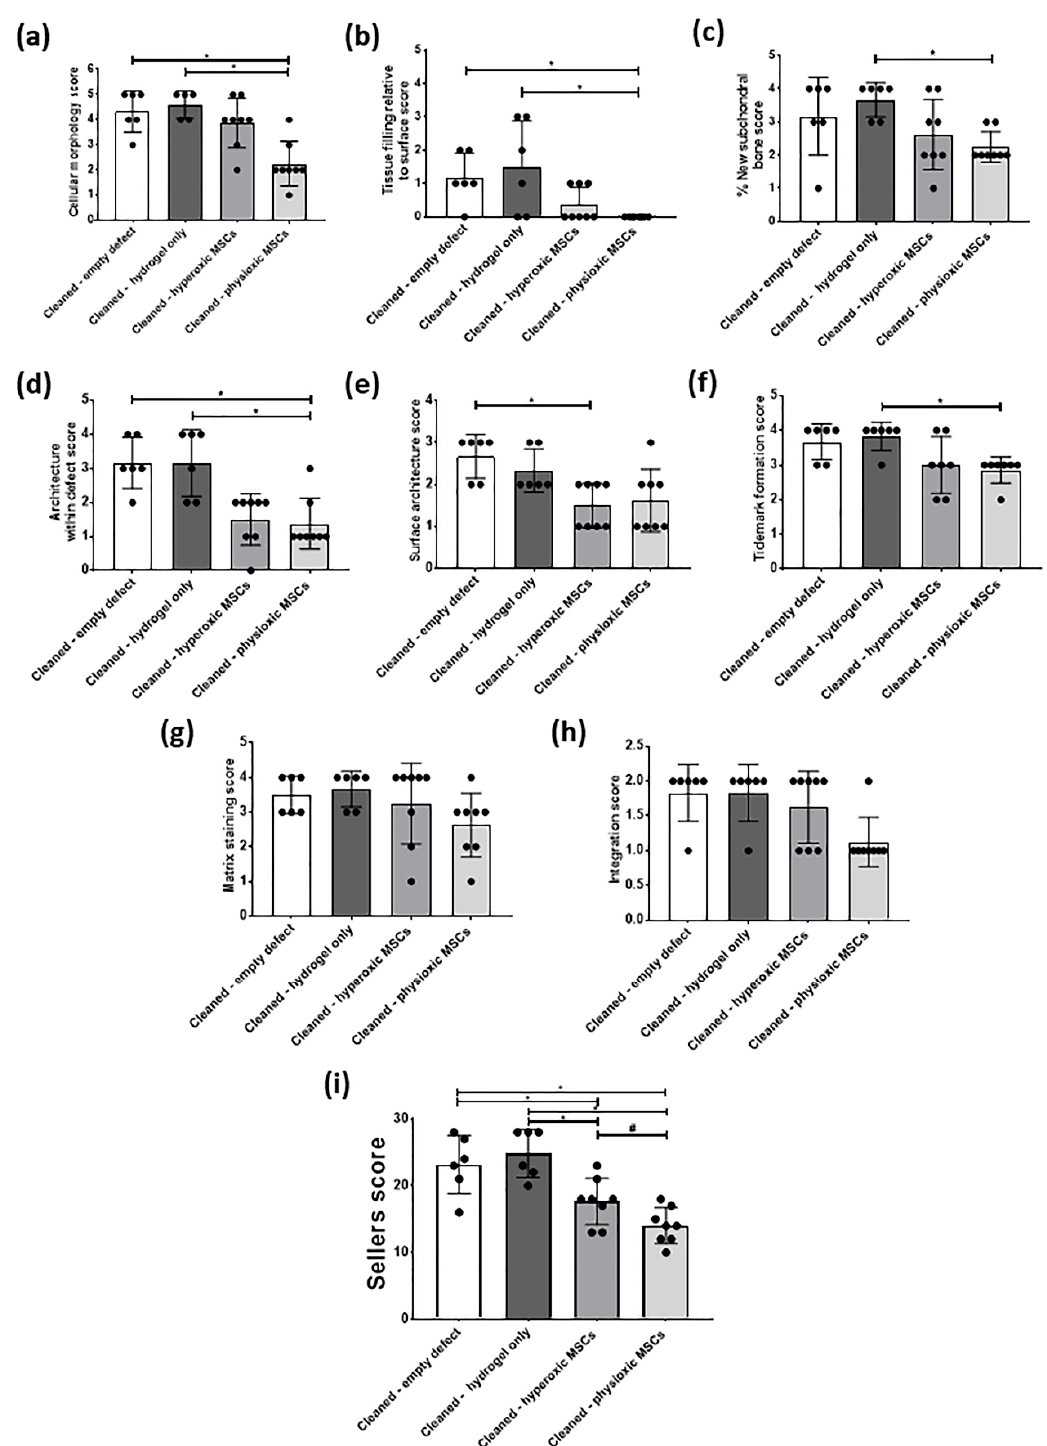
Figure 10. Individual scoring parameters of the Sellers score for ( a ) cellular morphology, ( b ) tissue filling, ( c ) % new subchondral bone, ( d ) architecture within the defect, ( e ) surface architecture, ( f ) new tidemark formation ( g ) new cartilage matrix staining, and ( h ) cartilage integration with surrounding cartilage between groups in a focal early OA model. * p < 0.05 from Kruskal-Wallis test with Dunn’s multiple comparison test. ( i ) The overall Sellers score for cartilage repair in a focal early OA model. * p < 0.05 from one way ANOVA with Tukey post-hoc test, # p < 0.05 from pairwise t-test. The data represent the mean ± S.D. of n = 6–8 rabbits with dots representing the mean from three blinded scorers (five sections per defect).